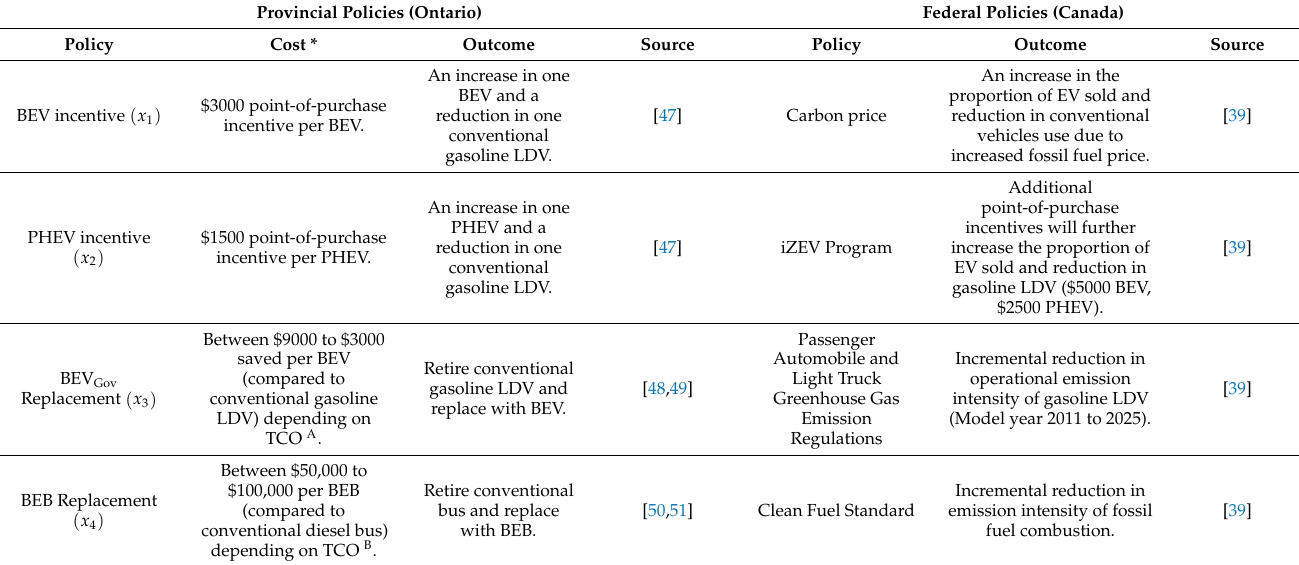
Table 1. Provincial policies, costs, and GHG reduction outcomes and background ongoing federal